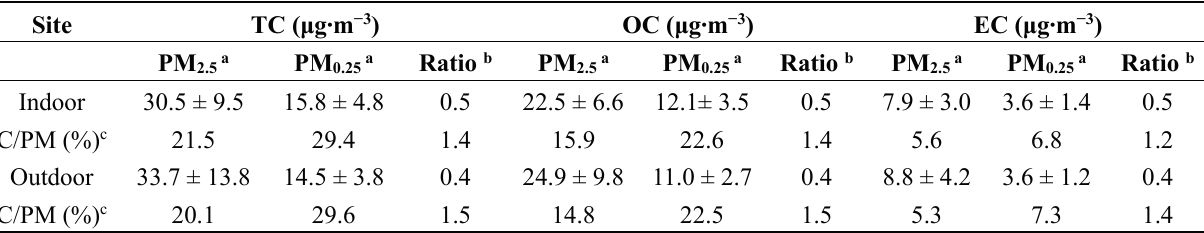
c Percentage of carbonaceous aerosol 0.25 to PM 2.5 ratio;